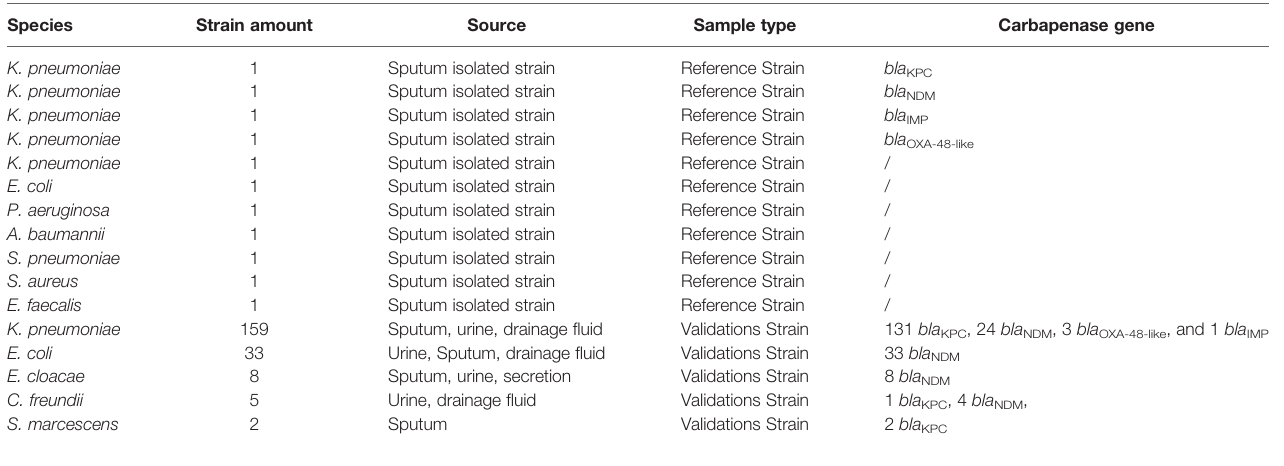
TABLE 1 | Information of bacteria strains used in this study.